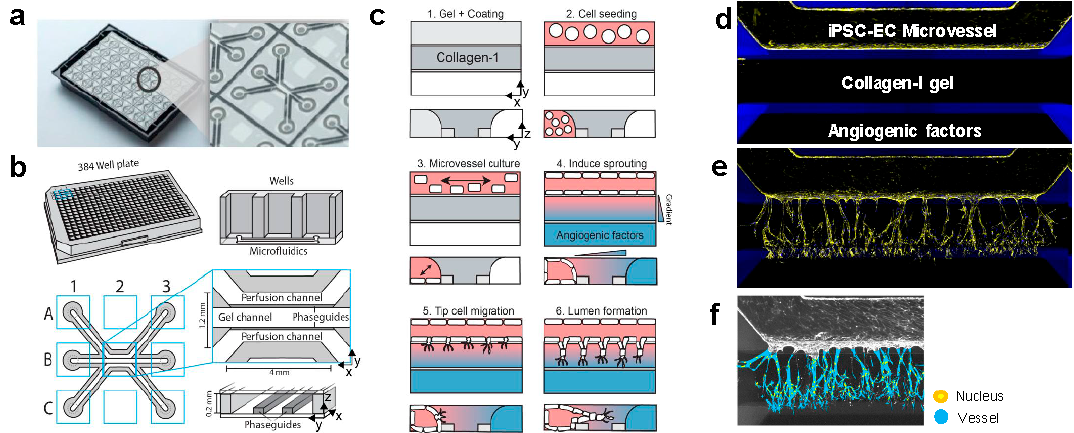
Figure 1. Angiogenesis assay of perfused induced pluripotent stem cell–endothelial cell (iPSC-EC microvessels. ( a ) Bottom of the microfluidic cell culture device. On the right 1 of 40 microfluidic units that are integrated underneath the 384-well plate is depicted. ( b ) Schematic overview of a single microfluidic unit/chip. The microfluidic channels are separated by ridges (‘phaseguides’), which enable the patterning of hydrogels in the central channel (‘gel channel’) while there is still contact with the adjacent channels (‘perfusion channels’). ( c ) Method to culture a microvessel within a microfluidic device and induce gradient driven angiogenic sprouting. ( d ) Microvessel 2 days after seeding iPSC-ECs as single cells. Cells form a monolayer against the patterned collagen-1 gel stained for F-actin (yellow) and nucleus (blue). ( e ) Gradient driven sprouting angiogenesis of iPSC-ECs after 2 days of stimulation with angiogenic growth factors. ( f ) Automated segmentation of vessel-like structures within the collagen-1 gel. Reproduced from van Duinen, V.; et al. Standardized and Scalable Assay to Study Perfused 3D Angiogenic Sprouting of iPSC-derived Endothelial Cells In vitro . J. Vis. Exp. 2019